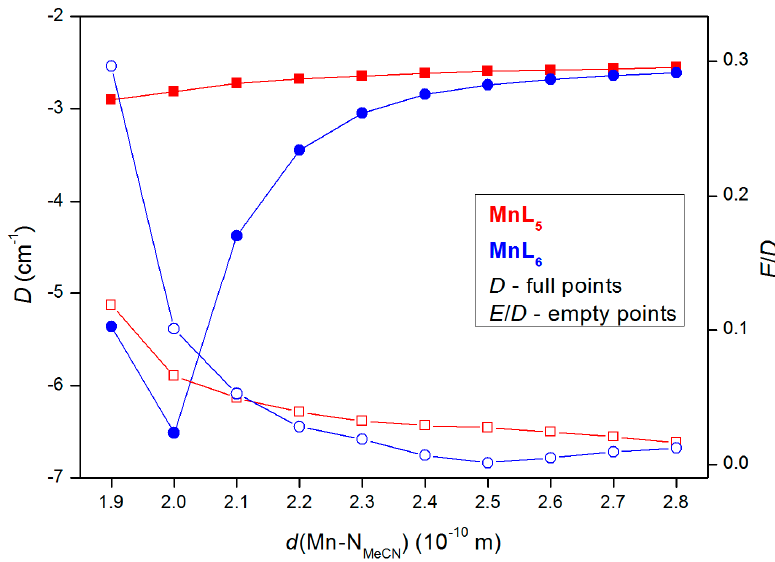
Figure 5. The CASSCF/NEVPT2 calculated magneto-structural correlation of ZFS parameters D and E for pentacoordinate [Mn(L4A)(MeCN)] + (MnL 5 ) and hexacoordinate [Mn(L4A)(MeCN) 2 ] + (MnL 6 ) model compounds for varying Mn – N MeCN distance(s) from 1.9–2.8 Å.